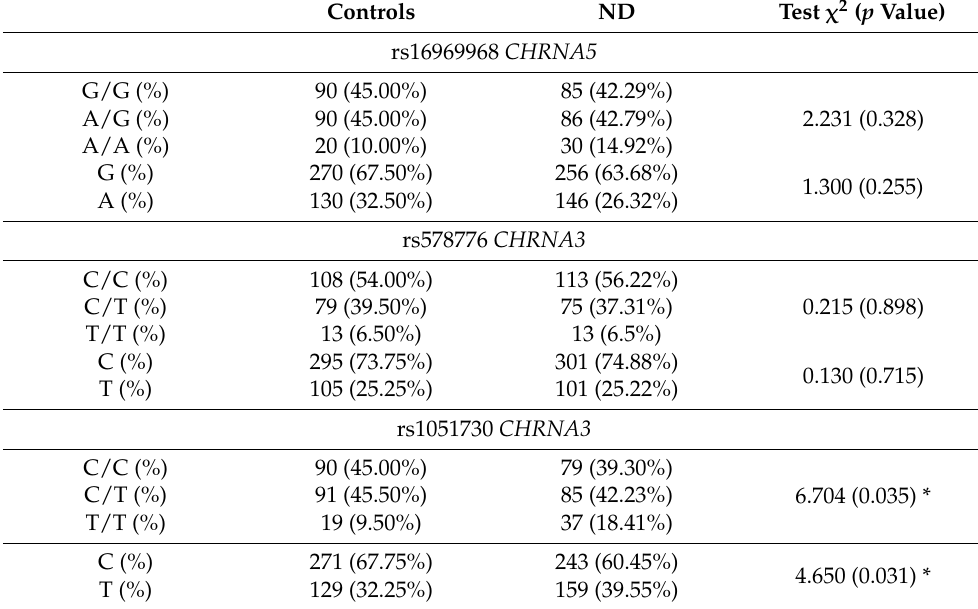
Table 2. Frequencies of genotypes and alleles of CHRNA5 rs16969968, rs578776 CHRNA3 , and rs1051730 CHRNA3 in the group of nicotine-dependent (ND) subjects and controls.